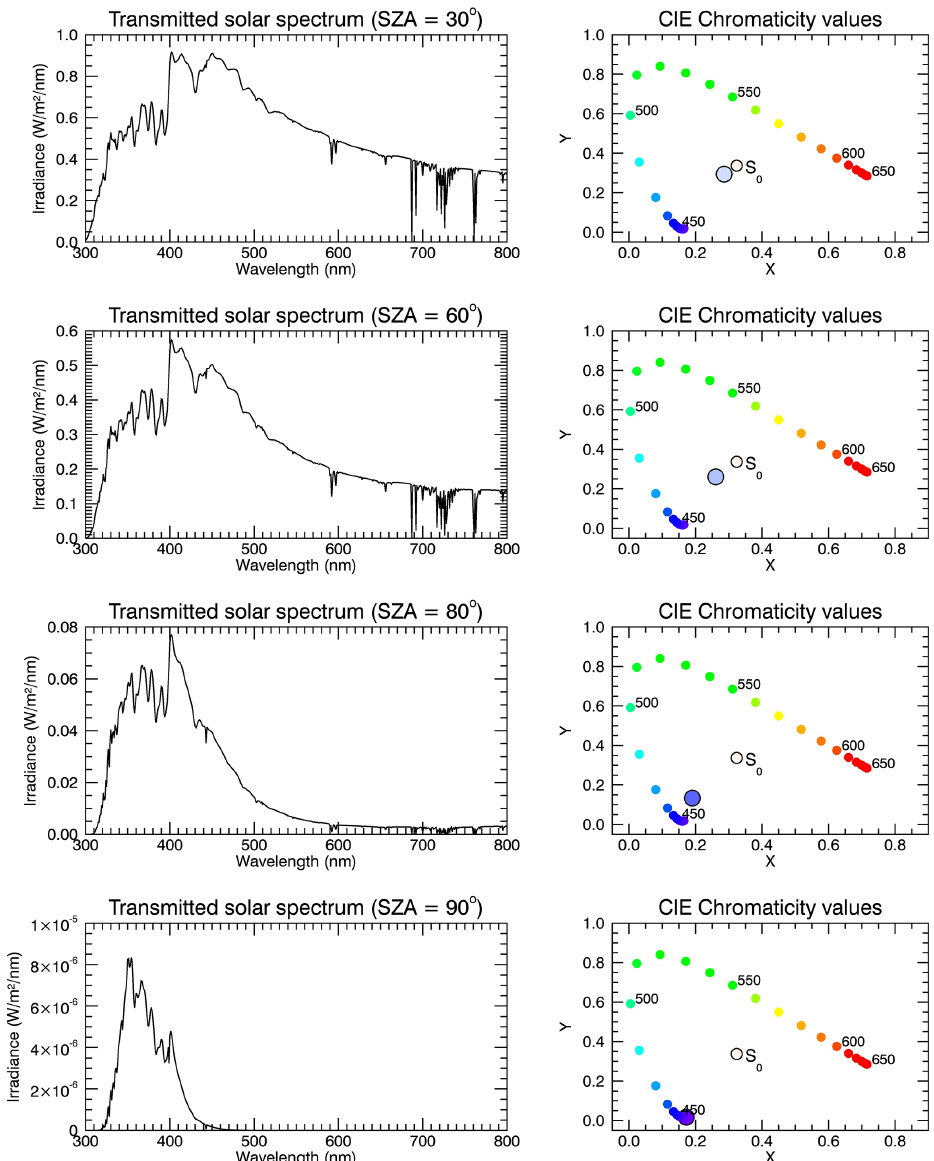
Figure 6. Similar to Fig. 4 but with Rayleigh scattering switched off. All other parameters are identical to those in Fig. 4; i.e. τ = 1, r m = 550nm, S = 1 . 05, layer altitude